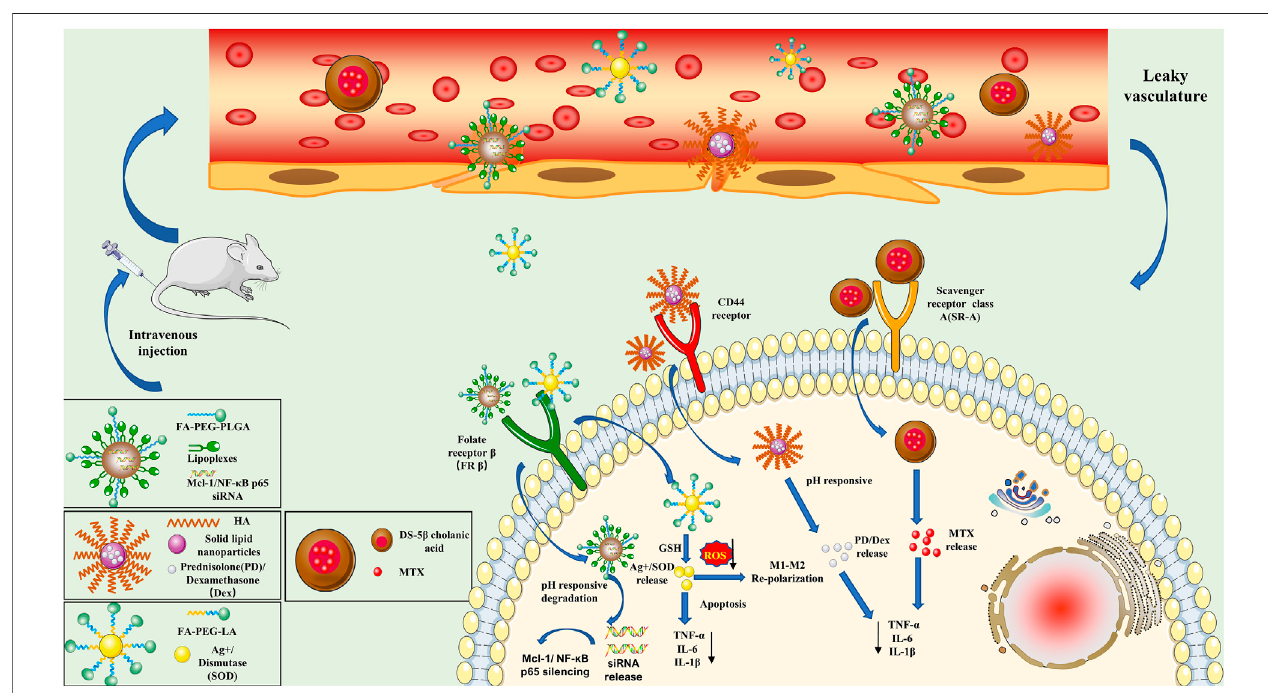
FIGURE 3 | Schematic illustration of the active targeting nanoparticles (NPs) approach in rheumatoid arthritis. (1) Mcl-1/NF- κ B p65 siRNA-NPs are fabricated by encapsulatingpoly-siRNAintolipid – polymerhybridNPs.Followingsystemicadministration,NPsaccumulateinthein fl amedjointsbytakingadvantageoftheleakyblood vessels and selectively delivering Mcl-1/NF- κ B p65 siRNA into activated macrophages through folate receptor – mediated endocytosis. (2) Ag+/SOD-loaded NPs dissolve and release Ag+/SOD in response to intracellular GSH, which synergistically induces apoptosis in M1 macrophages and scavenges ROS to cause the polarization of M1 macrophages to the M2 phenotype in in fl amed synovial joints. (3) PD/Dex is wrapped in HA-coated solid lipid NPs to prepare NPs for pH-responsive drug release. HA coating allows NPs to enter macrophages through CD44 receptor – mediated endocytosis, thereby reducing the release of TNF- α , IL-1 β , and IL-6. (4) Dextran sulfate acts as a ligand for macrophage scavenger receptor class A, which is overexpressed by activated macrophages. Nanoparticles enter activated macrophages to release MTX and inhibit the release of TNF- α , IL-1 β , and IL-6. Dex, dexamethasone; FA-PEG-PLGA, folic acid-poly (ethylene glycol)-poly (lactide-co- glycolide); FA-PEG-LA, FA-PEG-lipoic acid; GSH, glutathione; HA, hyaluronan; IL-1 β , interleukin-1 β ; IL-6, interleukin-6; Mcl-1, myeloid cell leukemia-1; MTX, methotrexate; NF- κ B, nuclear factor- κ B; PD, prednisolone; ROS, reactive oxygen species; siRNA, small interfering RNA; SOD, superoxide dismutase; TNF- α , tumor necrosis factor α